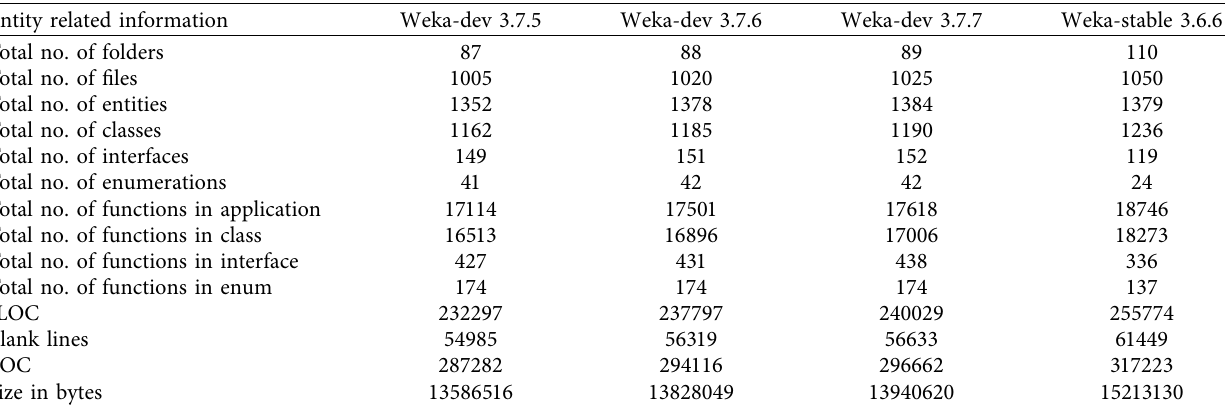
Table 4: Facts about entities in weka dataset.